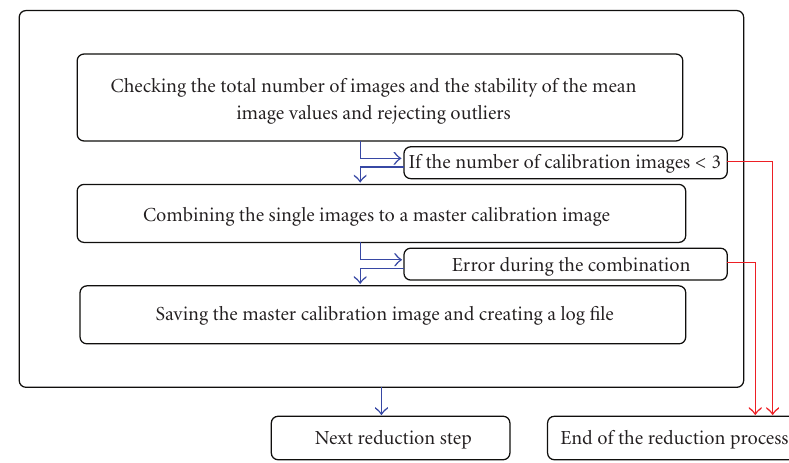
Figure 2: Flow chart with the main steps of building the master calibration images.